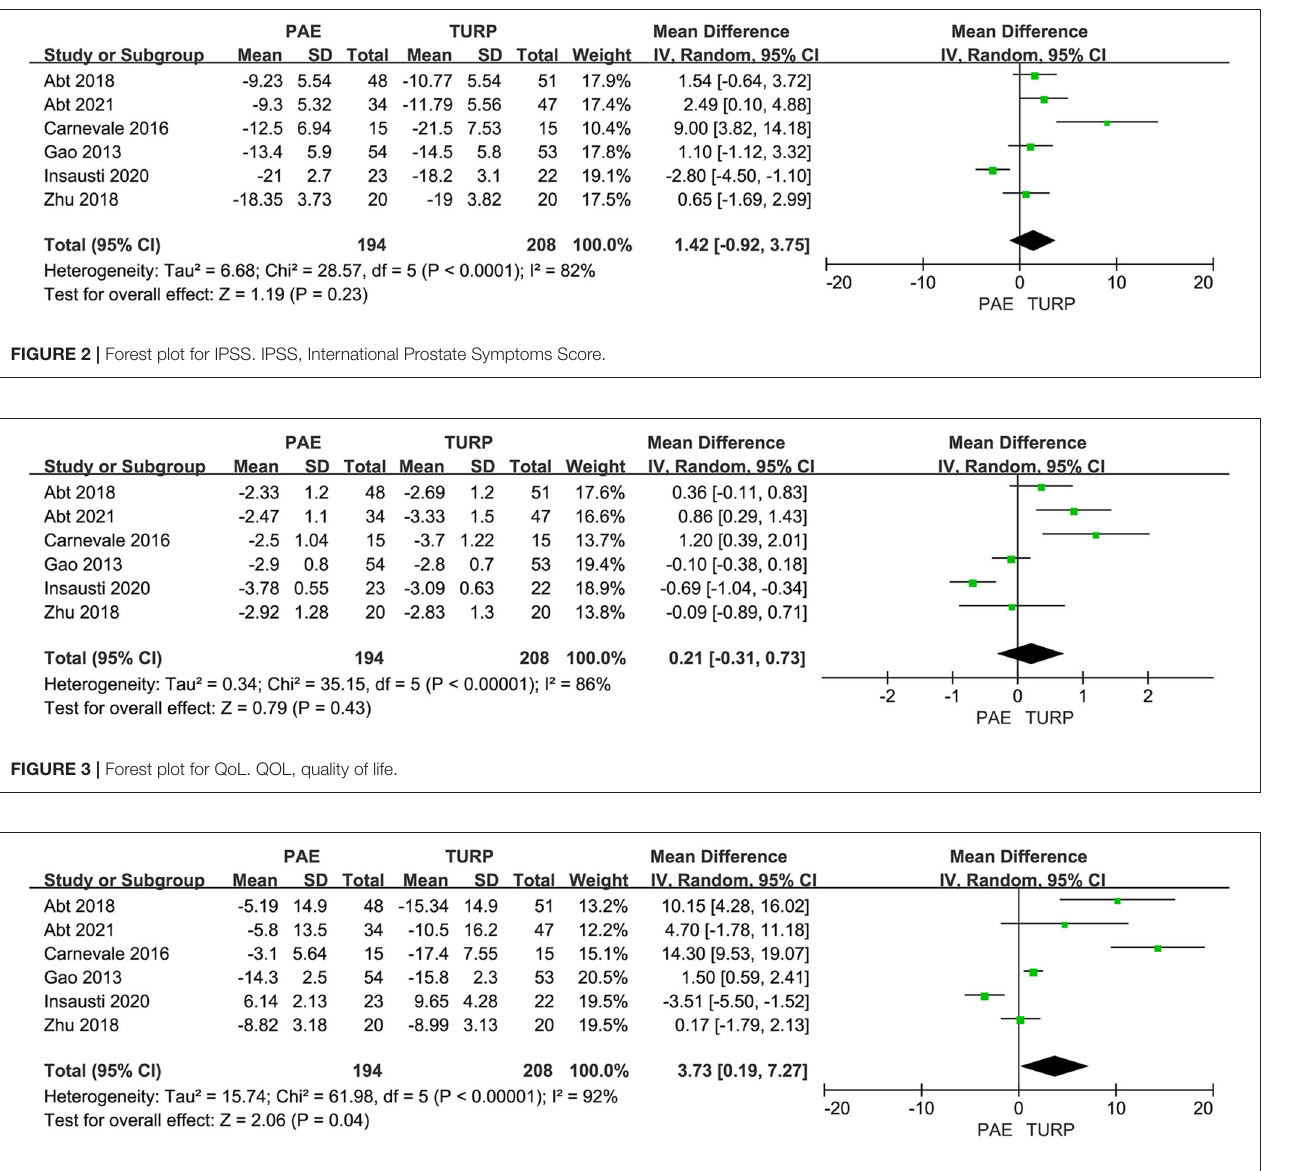
FIGURE 4 | Forest plot for Qmax. Qmax, maximum flow